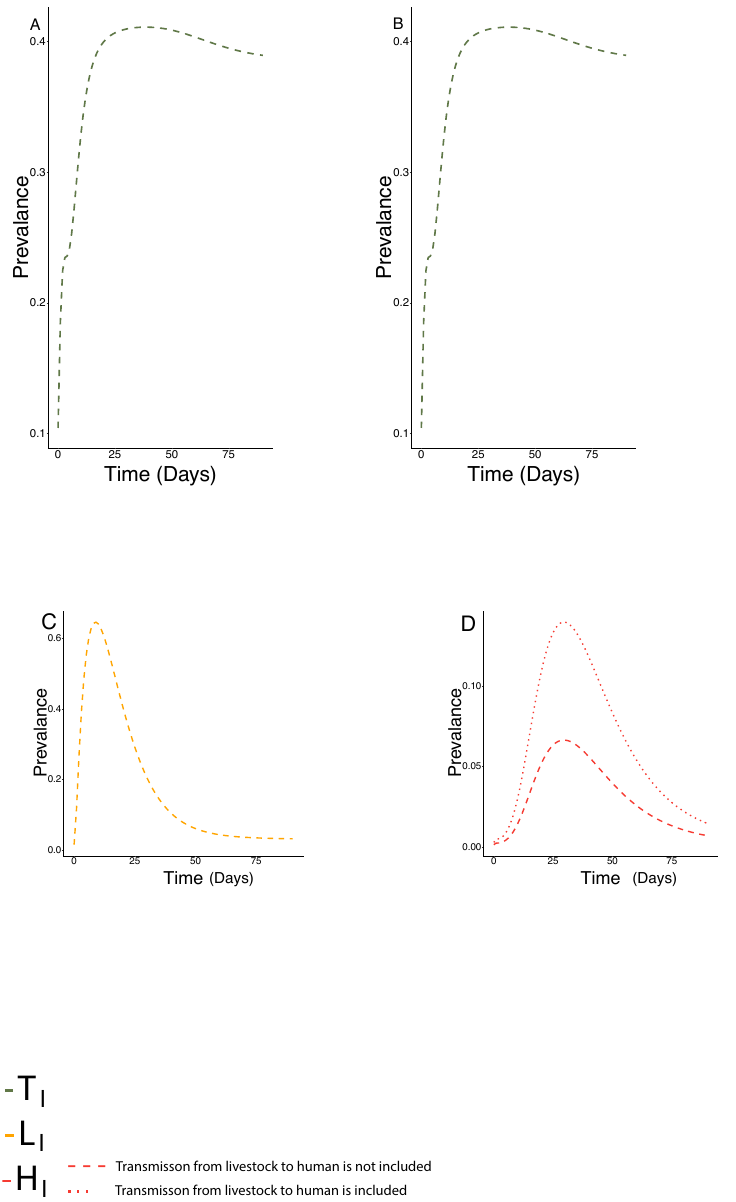
- - - Transmisson from livestock to human is not included H I Transmisson from livestock to human is included Figure 3. Simulated infection dynamics of models (1)–(3), (5) and (6). CCHFV prevalence in the effective tick population ( A , B ), livestock populations ( C ) and human ( D ) while considering in this instance both infectious and removed host populations according to [19].